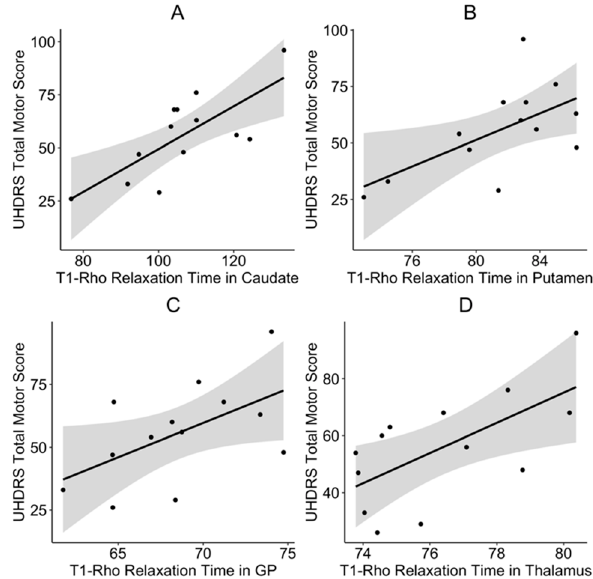
Figure 2. T 1 ρ relaxation times in the ( A ) caudate, ( B ) putamen, ( C ) globus pallidus, and ( D ) thalamus. Significantly predicted total motor scores as measured by the UHDRS. Results show raw data points, the fitted regression line of the model, and 95% confidence interval. GP: Globus pallidus; UHDRS: Unified Huntington’s Disease Rating Scale.